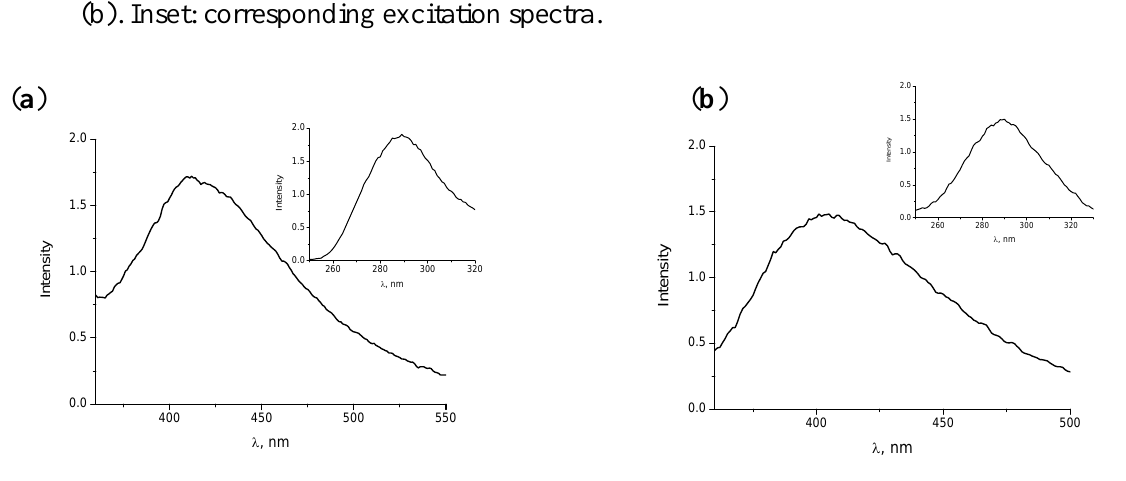
= 280 nm) spectra of 2 in DMSO (a) and in ethanol exc